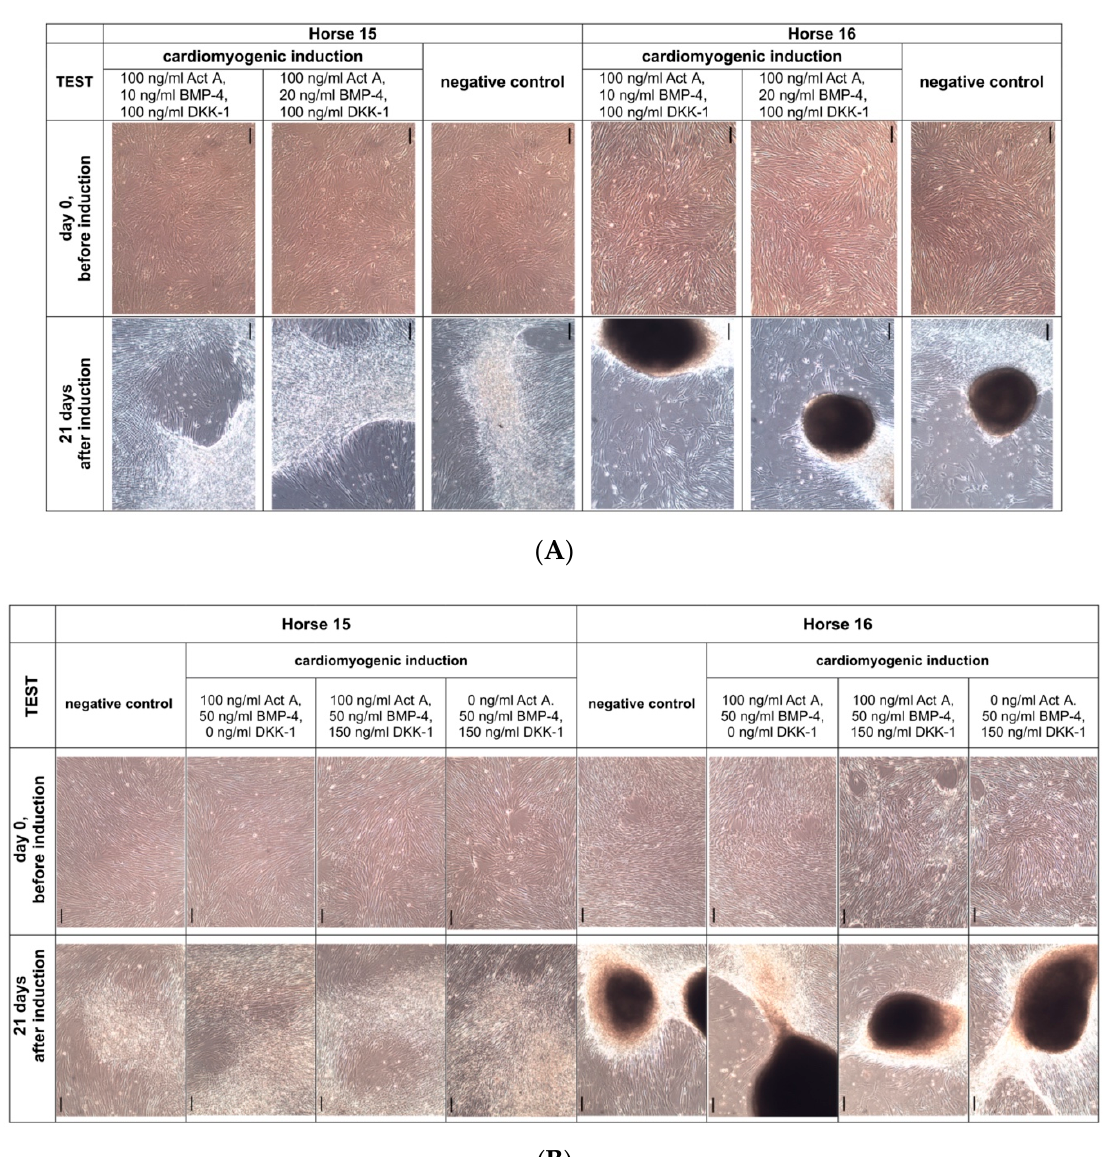
Figure 6. Application of substances for cardiomyogenic differentiation. Cell morphology of equine adipose-derived stem cells exposed to different concentrations of activin (Act) A, bone morphogenetic protein (BMP)-4 and Dickkopf (DKK)-1 in ( A ) a first and ( B ) a second sub-experiment. Cell morphology of two representative horses is shown before (day 0) and 21 days after cardiomyogenic induction. Neither relevant differences between the induced cells and non-induced negative controls nor a cardiomyogenic differentiation could be detected. Cells retained their fibroblast-like cell morphology and formed “domes”, which were more obvious in horse 16 compared to horse 15, particularly three weeks after induction. Scale bar: 100 µm (10× objective).